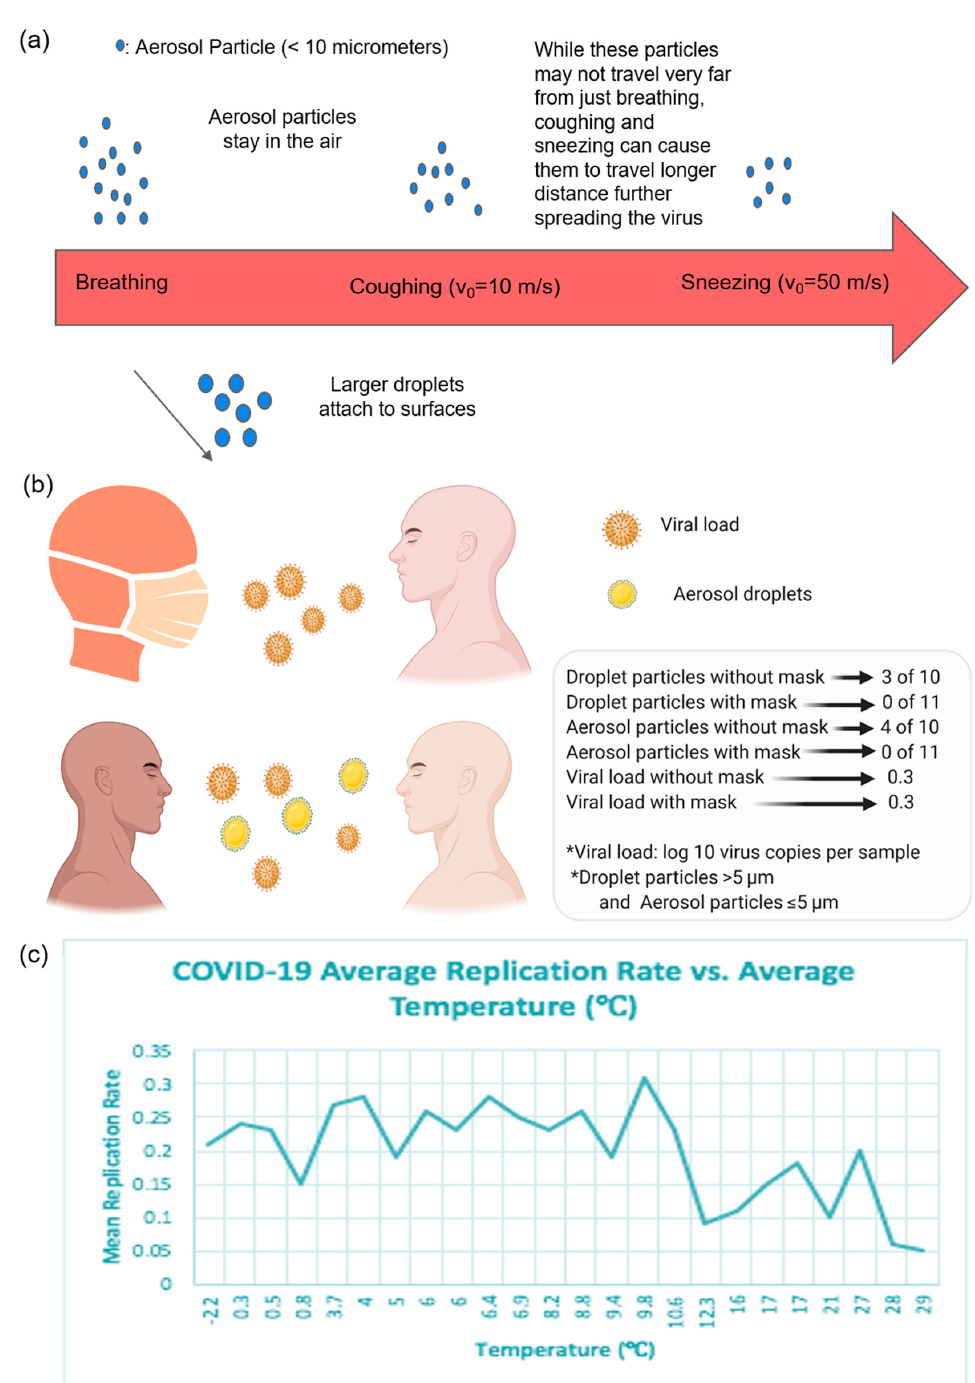
Figure 2. SARS-CoV-2 air travel, mask’s effect on transmission, and temperature dependence. ( a ) The spread of virus particles depending on coughing and sneezing, as well as particle size. The mode of ejection affects velocity and distance traveled, while the size affects the ability to stay in the air; ( b ) The difference in the spread of viral load and aerosol droplets with a mask and without a mask; ( c ) The relationship between the mean replication rate of SARS-CoV-2 and the temperature of 24 different countries is demonstrated. There is a moderate negative correlation between the mean replication rate and temperature, with a p value < 0.001. Data were taken from Caspi et al. [55] “Climate Effect on COVID-19 Spread Rate: An Online Surveillance Tool” with permission.